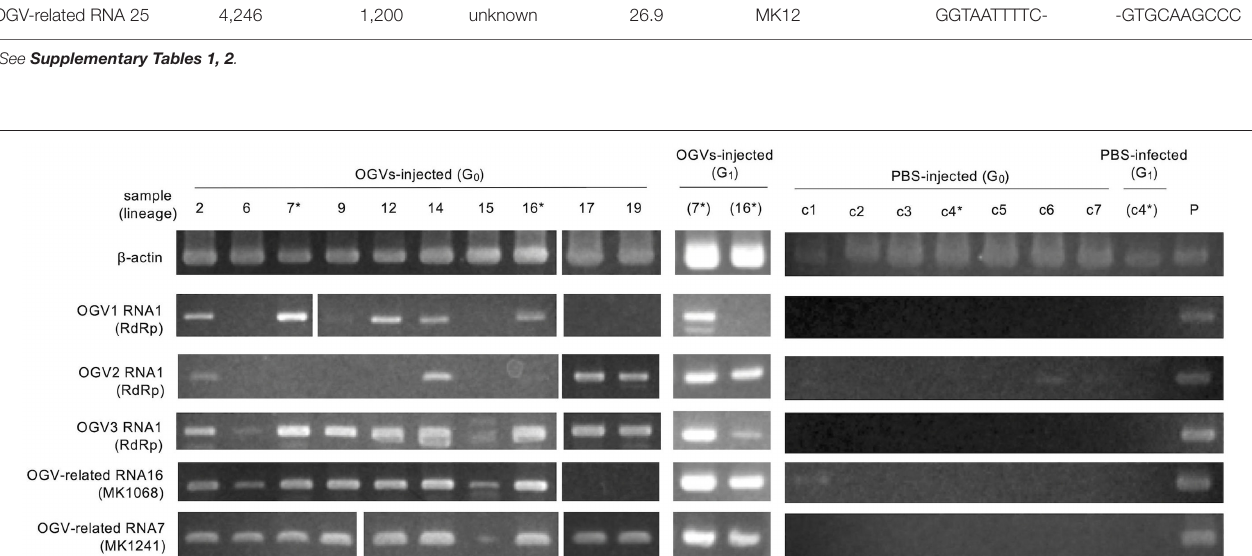
Frontiers in Microbiology |